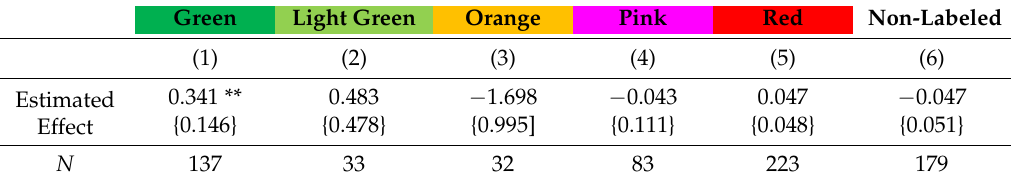
Table 4. Effect of providing Nutri-Score Label information on expenditure by color, conditional on buying at least one item of a given